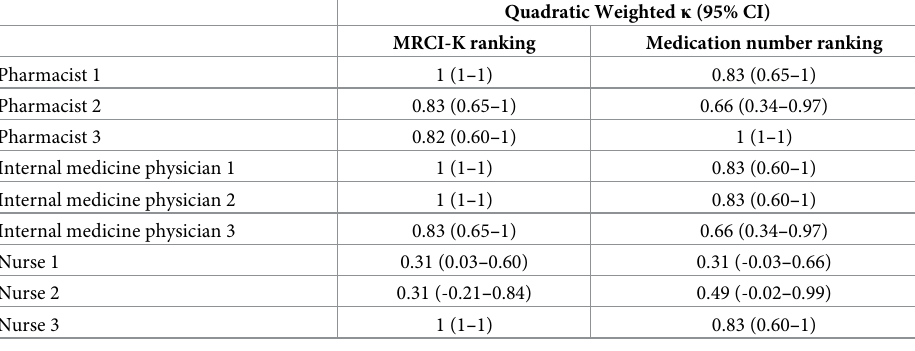
Table 4. Concordance of expert panel ranking with MRCI-K score and medication count rankings quadratic weighted κ (95%